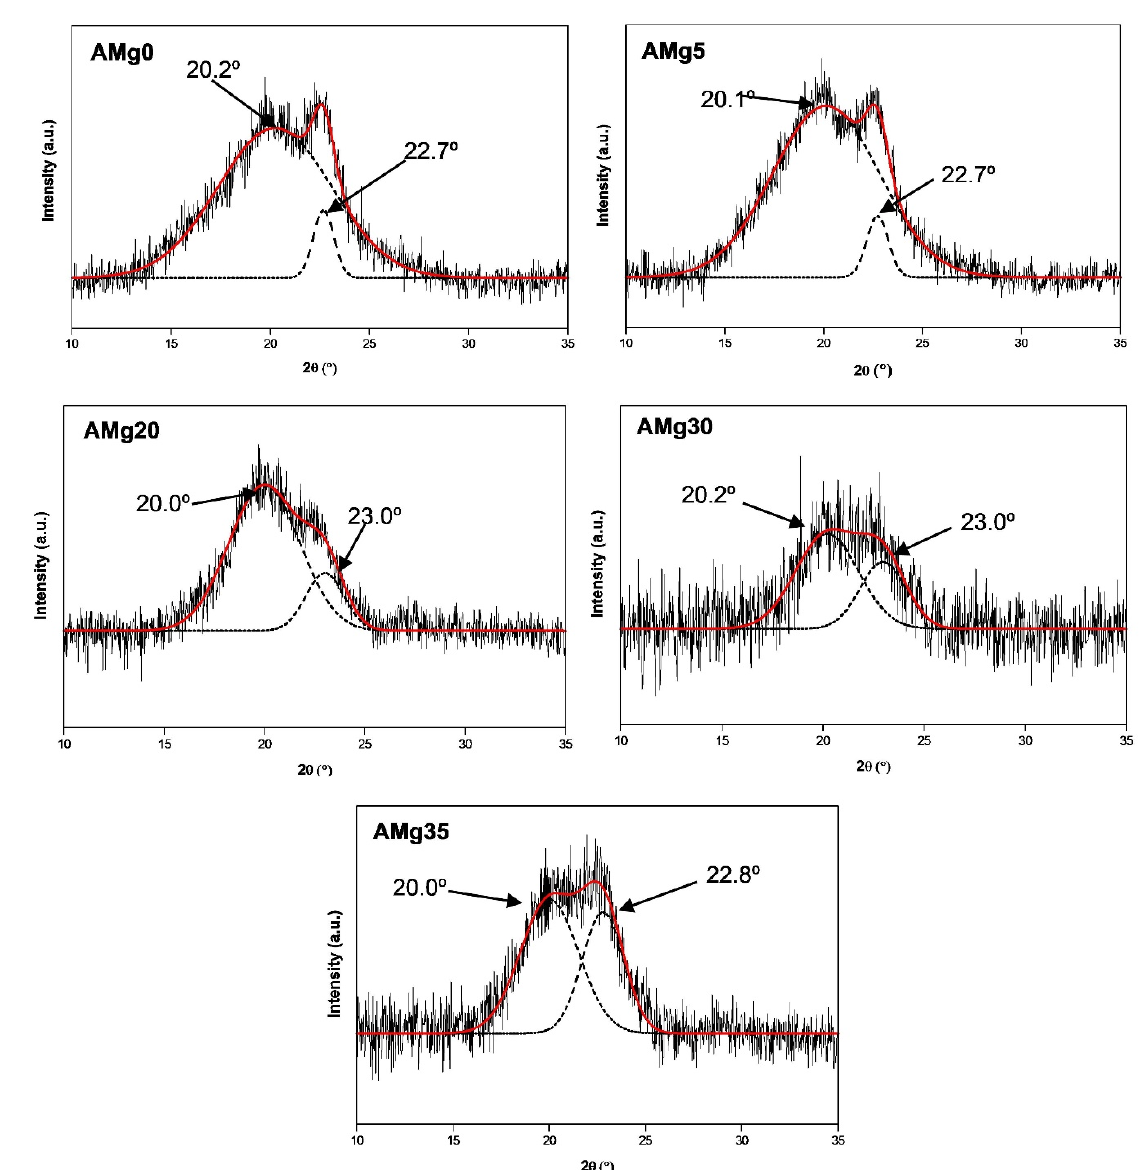
Figure 9. XRD deconvolution for different concentrations of agarose–Mg(NO 3 ) 2 polymer electrolytes. Table 1. The degree of crystallinity, 𝑋 (cid:3030) and size of crystallite, L of selected agarose–Mg(NO 3 ) 2 pol ‐ ymer electrolyte samples.